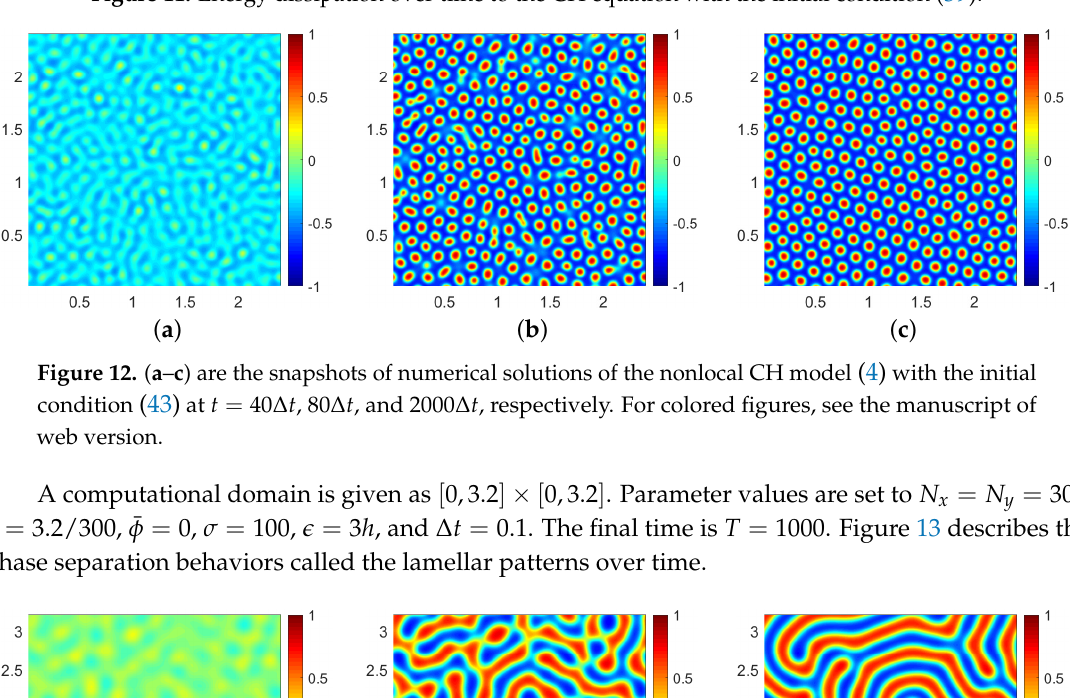
Figure 11. Energy dissipation over time to the CH equation with the initial condition (39) .